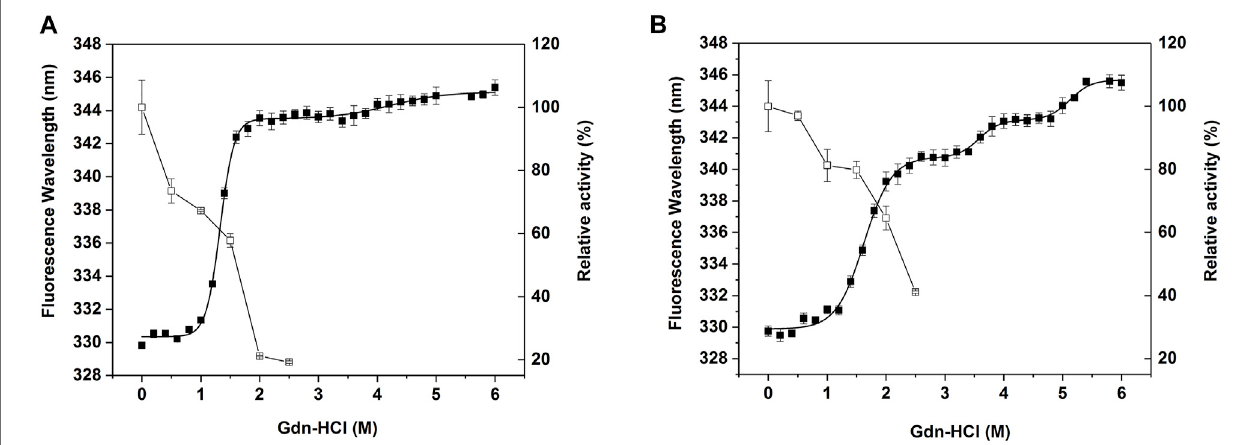
FIGURE 5 | Equilibrium unfolding and chemical inactivation of (A) CjLPMO10A cd and (B) M1 in guanidine hydrochloride (Gdn-HCl). Enzymes were incubated in different concentrations of Gdn-HCl for 24 h and then assayed for residual activity ( □ ) and fl uorescence spectra ( ■ ). The residual activity was measured at 30 ° C, the activity in the absence of Gdn-HCl was considered to be 100%. The fl uorescence spectra were recorded at wavelengths between 300 and 400 nm with an excitation wavelength at 280 nm. The maximum emission wavelength was plotted against the concentration of Gdn-HCl, and the curve was fi tted to the three-state or four- state equilibrium model. All experiments were performed in